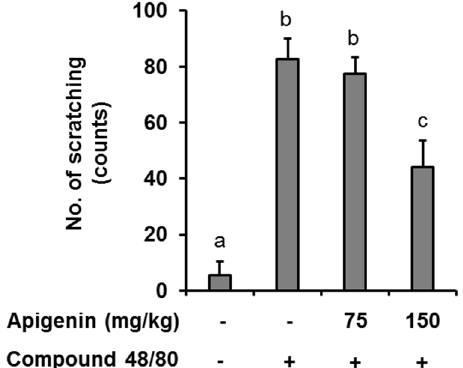
Figure 4. Effects of apigenin on compound 48/80 itch in mice. Five mice each were placed into four groups: Compound 48/80 negative control; compound 48/80 positive control; compound 48/80 with apigenin 75 mg/kg treatment; and compound 48/80 with apigenin 150 mg/kg treatment. Compound 48/80 (50 μg/site, 0.1 mL each) was injected into the dorsal dermis of the mice neck 60 min after administration of 2% geletin or apigenin at indicated concentrations. The number of scratches were monitored with micro-cameras for 30 min and counted in a double-blinded manner. Data are presented as the mean ± SEM of five mice per group. Bars with different small case letters indicated statistically significant difference at p < 0.05.